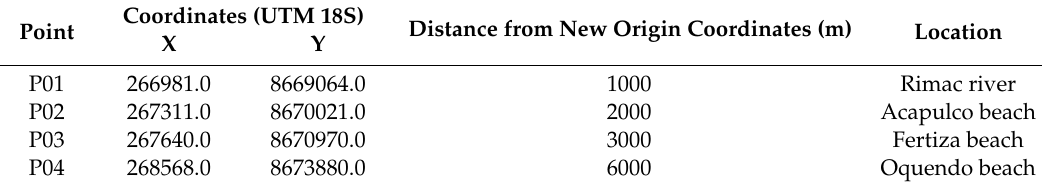
Table 3. Control point coordinates in the UTM system.